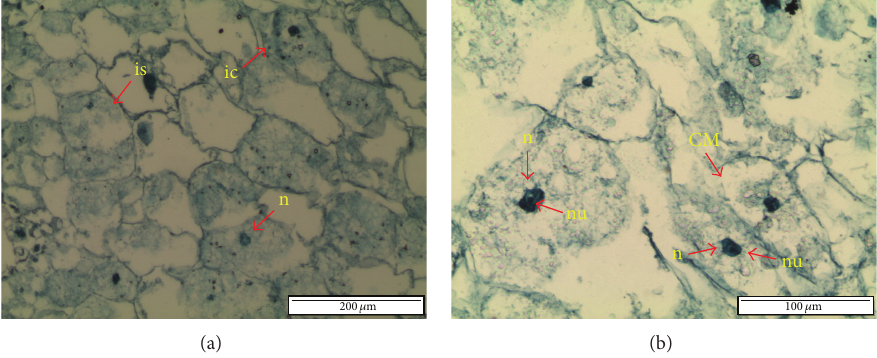
Figure 1: Cross-section of stock culture PLB. (a) The cells were intact with isodimetric shape and nucleus in central position. (b) Nucleus contains nucleolus and mitotic activities were observed (CM: cell mitosis; ic: intact cell; is: isodiametric; n: nucleus; nu: